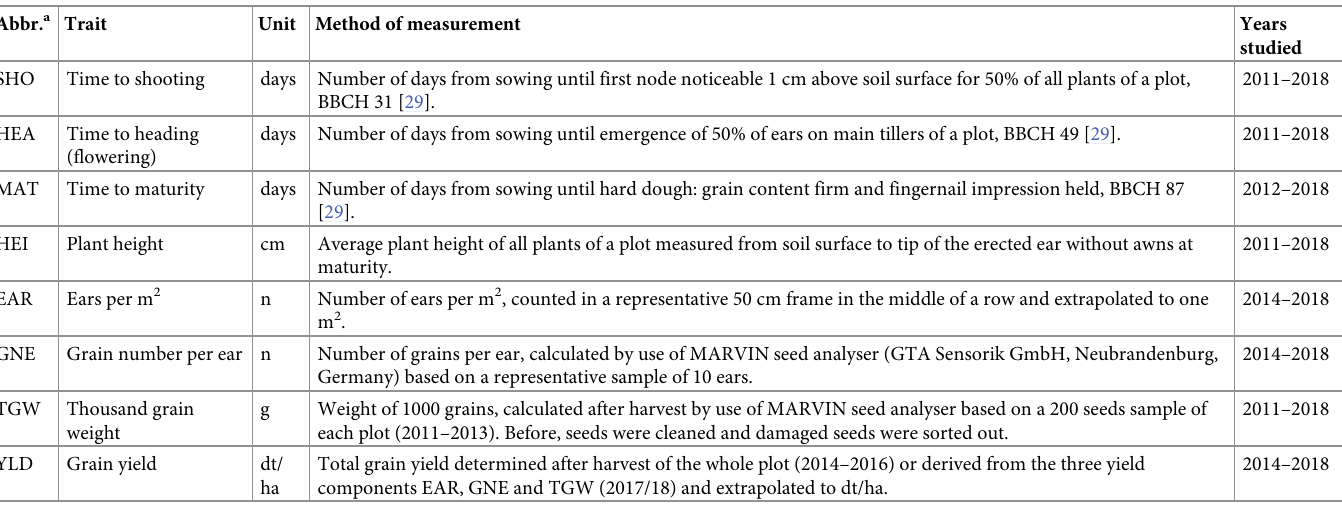
Table 1. List of evaluated traits for HEB-25 in eight-year field trials. Abbr. a Trait Unit Method of